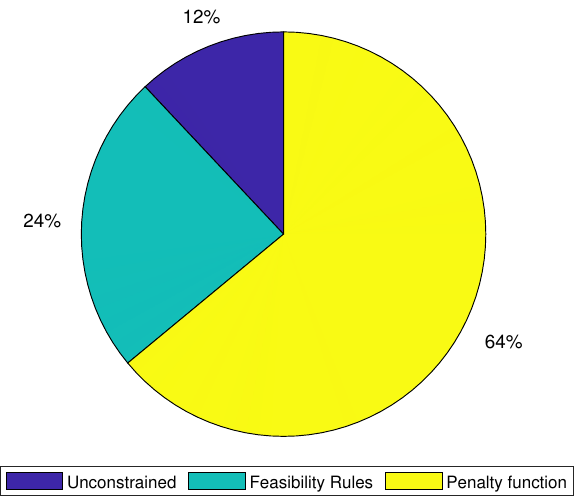
Figure 1. Use of the constraint-handling techniques in the optimal synthesis of mechanisms with metaheuristic algorithms according to Table